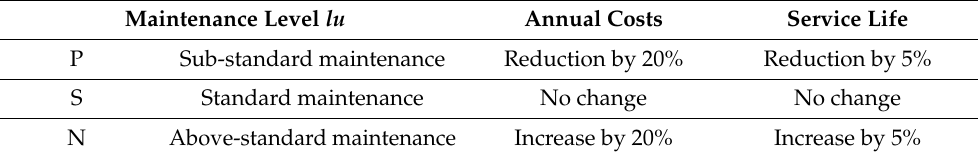
Table 2. Maintenance